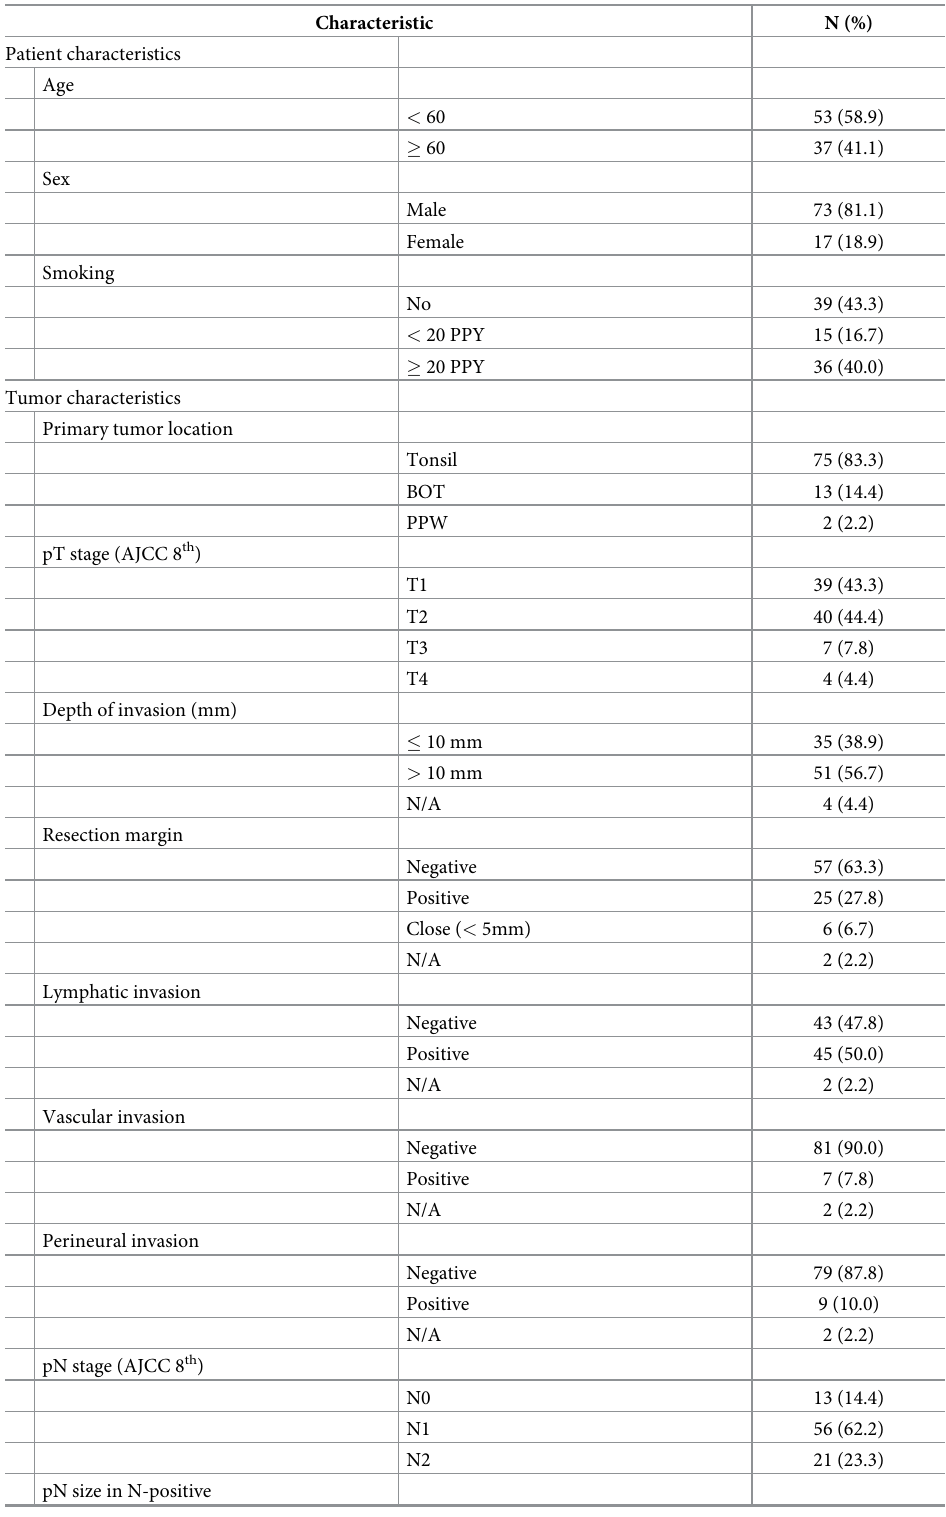
Table 1. Patient, tumor, and treatment